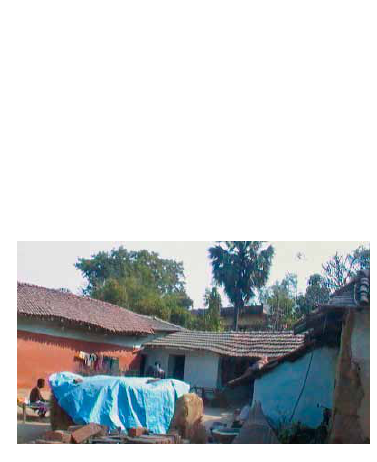
fig. 12. u-shaped dwelling unit with south side open